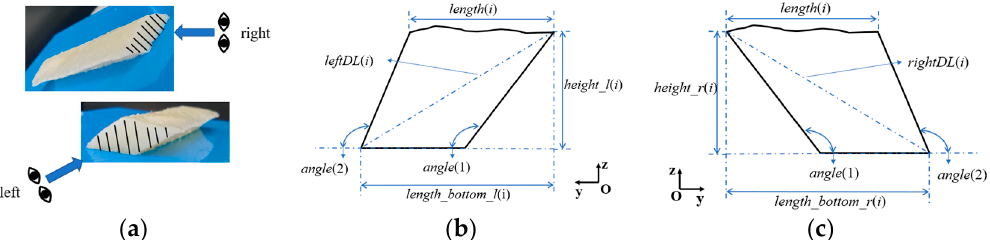
Figure 6. Diagonal length calculation method. Looking at the side of the fish from the left and right directions in ( a ), you can obtain the simplified image on the left side ( b ) and the simplified image on the right side ( c ).